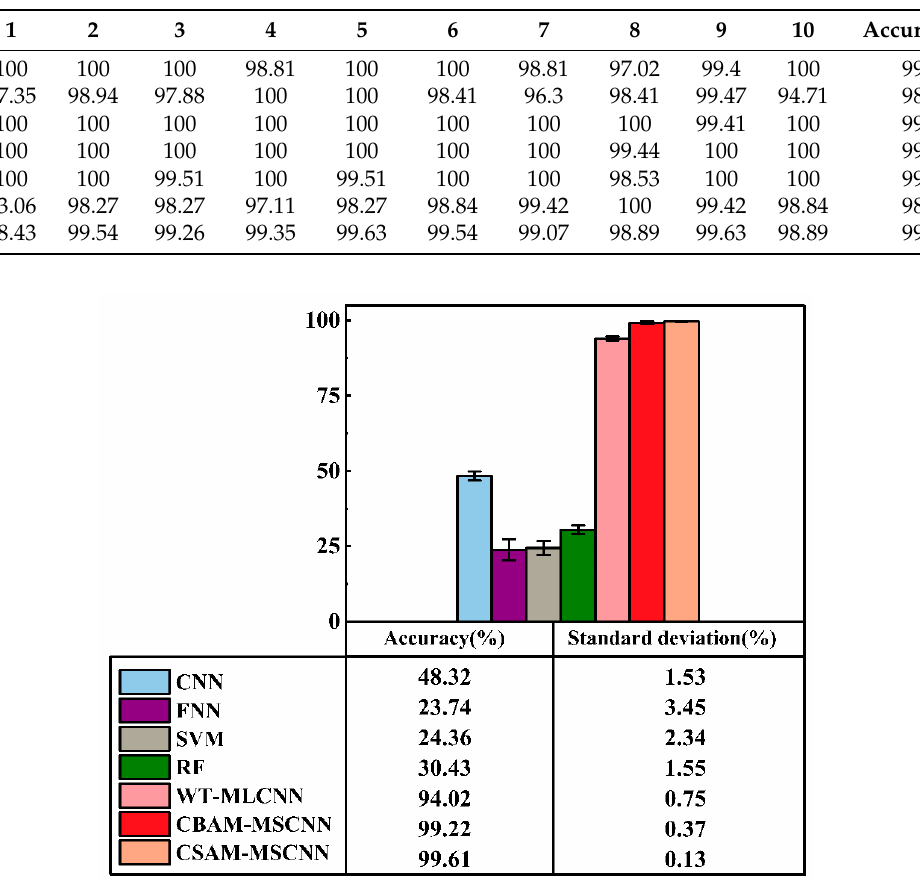
Table 11. Parallel experimental results of the CBAM-MSCNN.